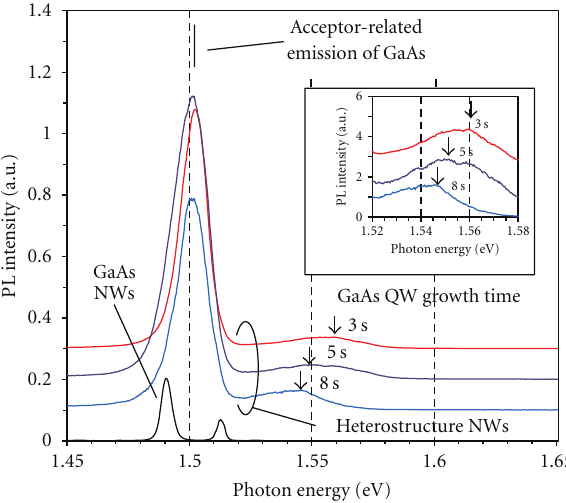
Figure 9: PL spectra for three types of heterostructure NWs with a GaAs QW grown for 3, 5, and 8 sec and GaAs NWs (as a reference) measured at 4.2K. NW pitch was 1 μ m for all the NW samples. Inset is enlarged spectra for the GaAs QWs